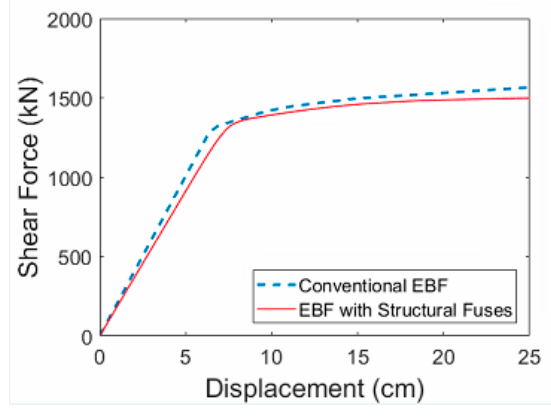
Figure 8. Pushover curves comparison of the two systems.